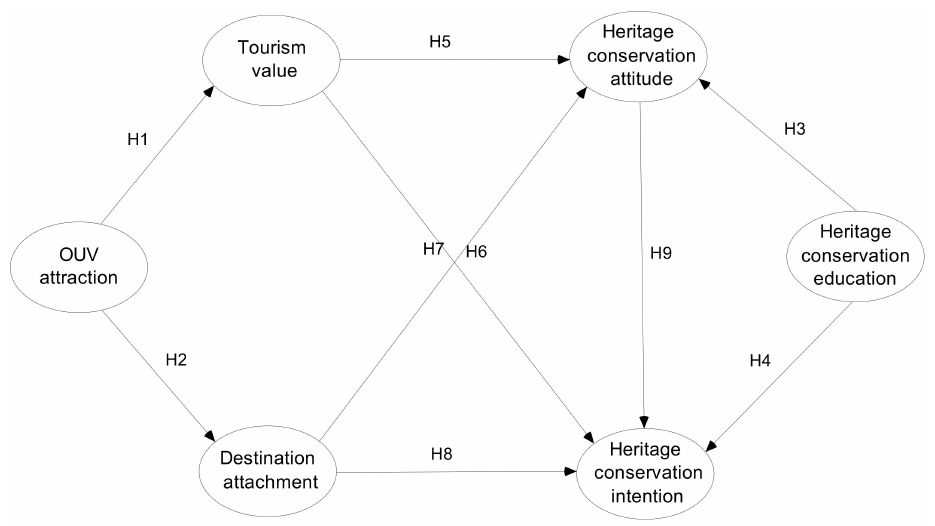
Figure 1. The proposed conceptual